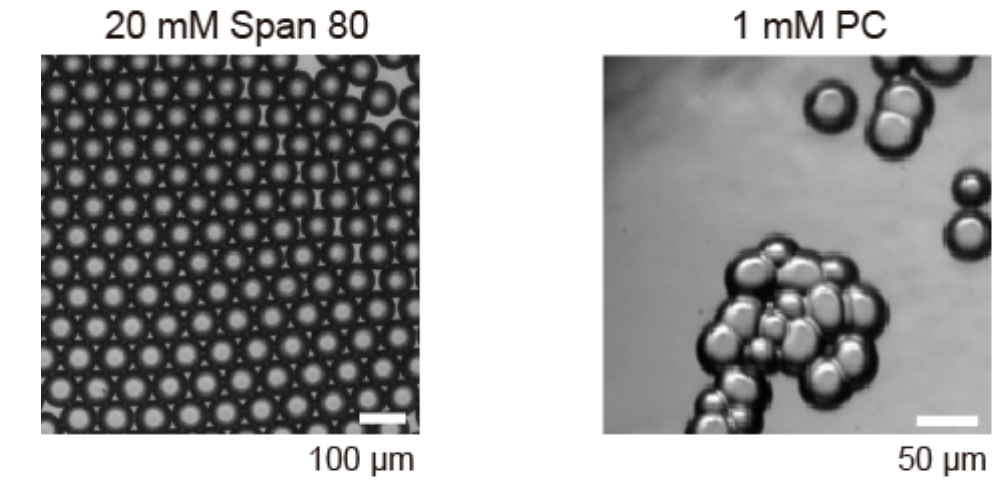
Figure 3. Microscopic images of droplets prepared in microfluidic device using oil with 20 mM Span 80 ( left ) and 1 mM PC ( right ). Flow rate ratio between water phase and oil phases, Q w / Q o , was fixed as 0.1 with Q o = 300 μ L/h.